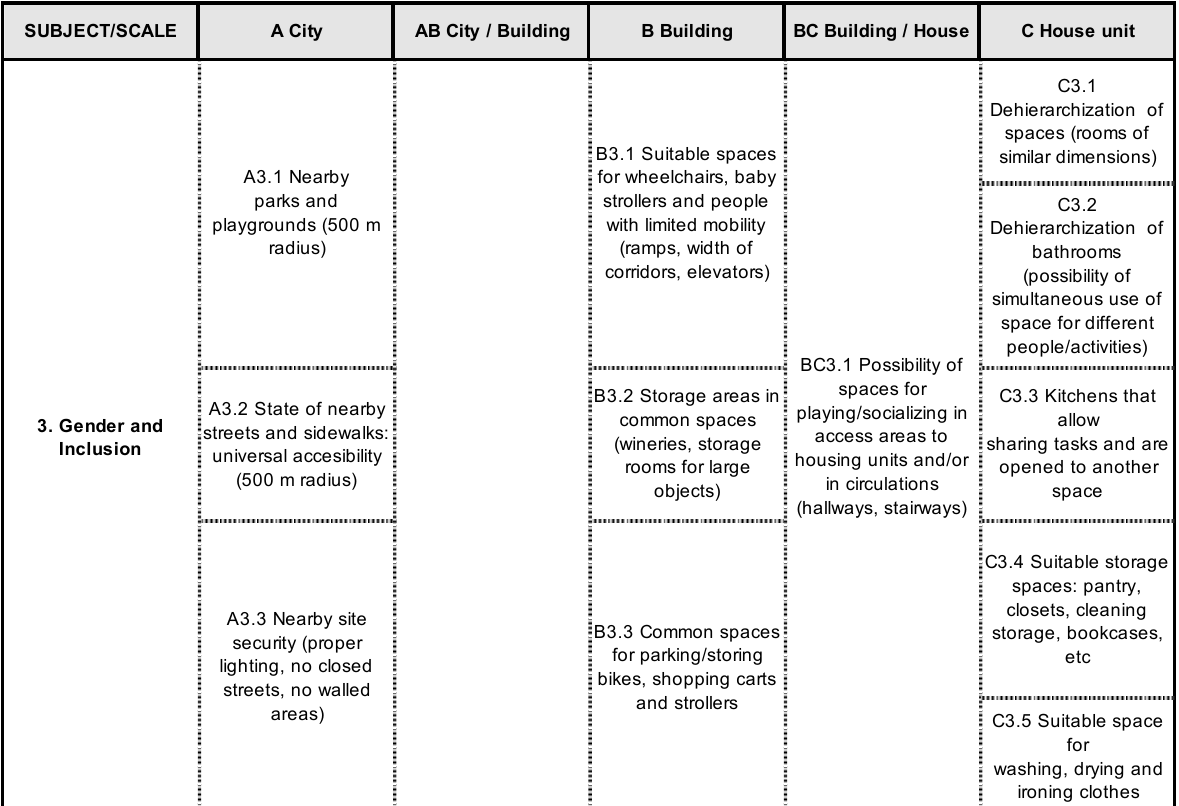
Figure 3. Gender and Inclusion Indicators. Source: Own elaboration Category 4: Spatial Quality indicators are related to materiality, architectural quality,